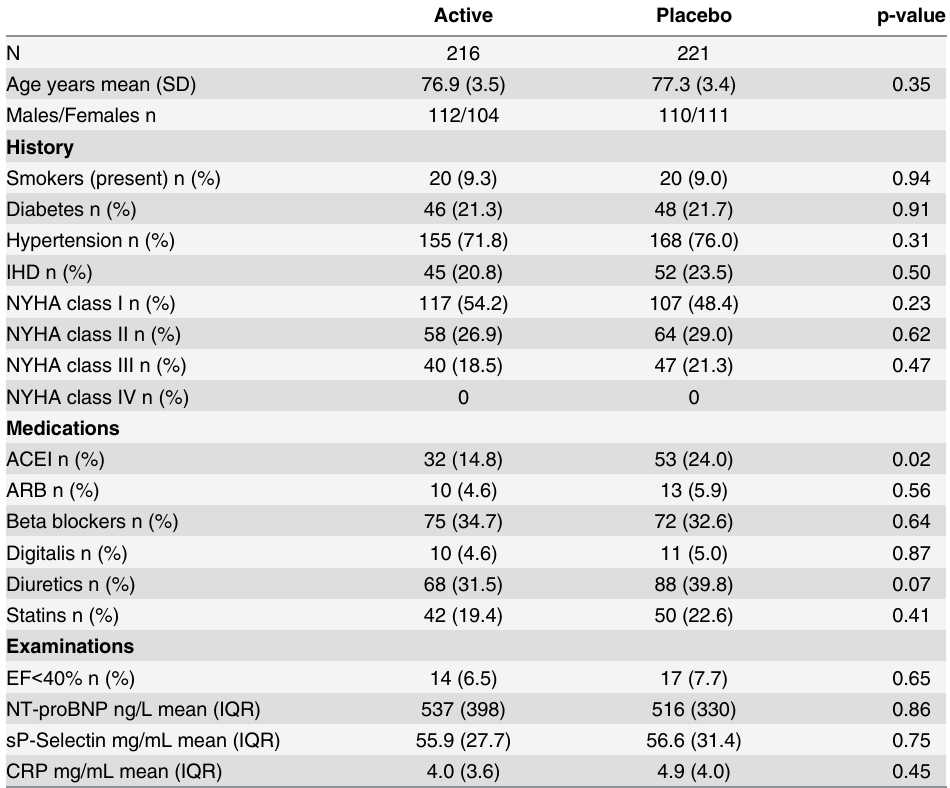
Table 1. Baseline characteristics of the study population receiving intervention of a dietary supple- mentation of selenium and coenzyme Q10 combined during 4 years. Active Placebo p-value